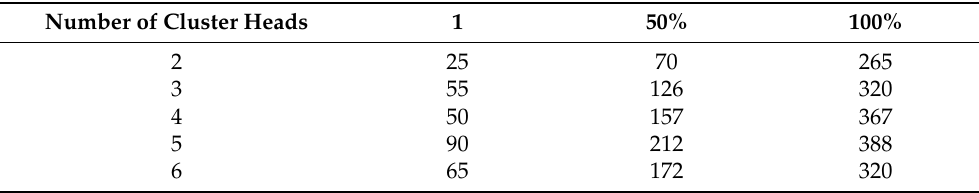
Table 6. Network life cycle comparison.